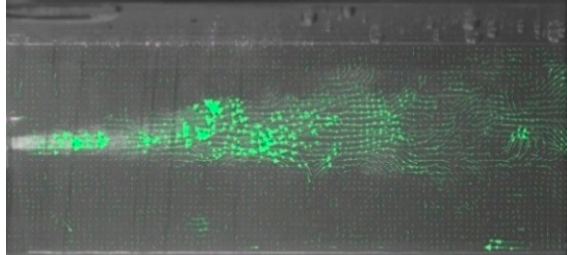
Figure 4. Velocity vector of the testing area.